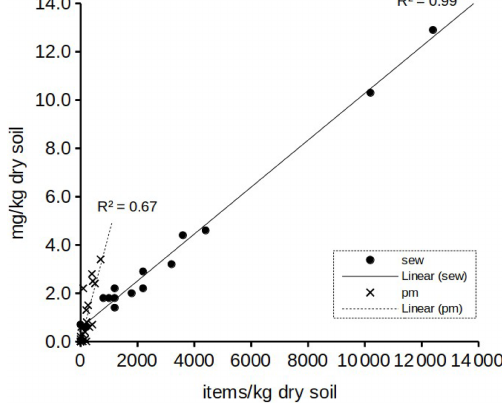
Figure 5. Regression of item and mass concentrations. Data were taken from sites with both measures ( n = 38). Dots represent mea- surements in soils with sewage sludge application and crosses ( × ) are those with plastic mulching. Linear trends are shown with